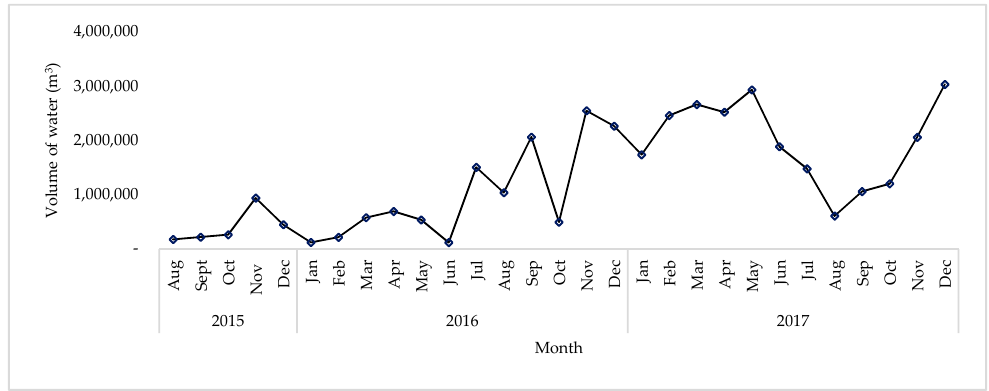
Figure 9. Pumping water from Bendili pit.